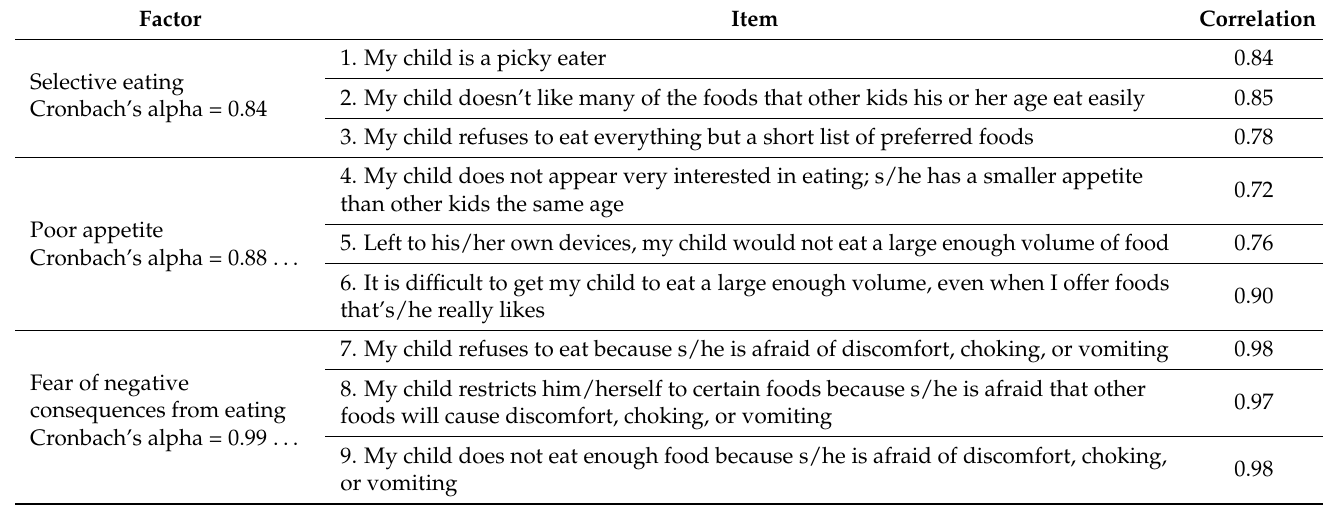
Table 8. Analysis of the reliability of the NIAS-PR (N = 167). Item Correlation